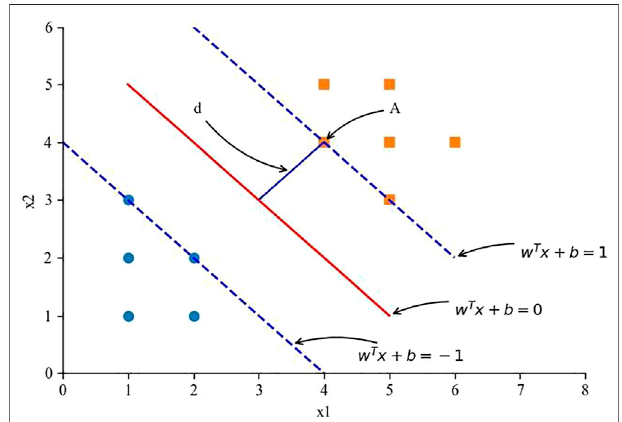
FIGURE 6 | Interval and support vector